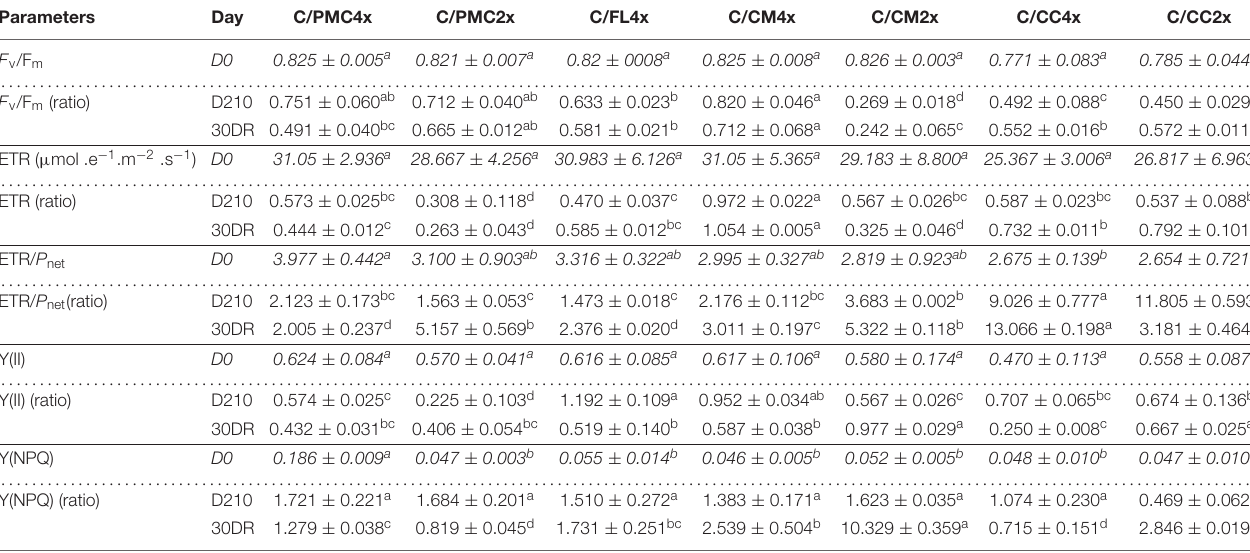
Data shown at D210 and 30DR are means (n = 3 ± standard error) expressed as ratios with respect to the values obtained on control which have not been subjected to stress. For further informations, means values of control data (D0) (n = 3 ± standard error) were also included and indicated by italics characters. Data were analysed using ANOVA and Fisher LSD tests (P < 0.05). Different letters indicate significant differences between genotypes along the time course. D0, control, D210, 210 days after the start of nutritional deprivation, and 30DR, after 30 days of